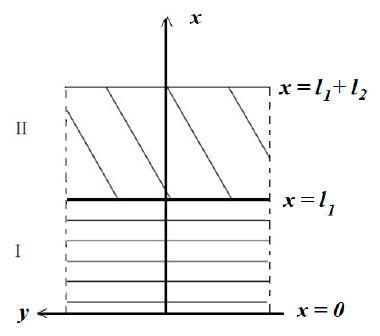
Figure 1. A layered medium.